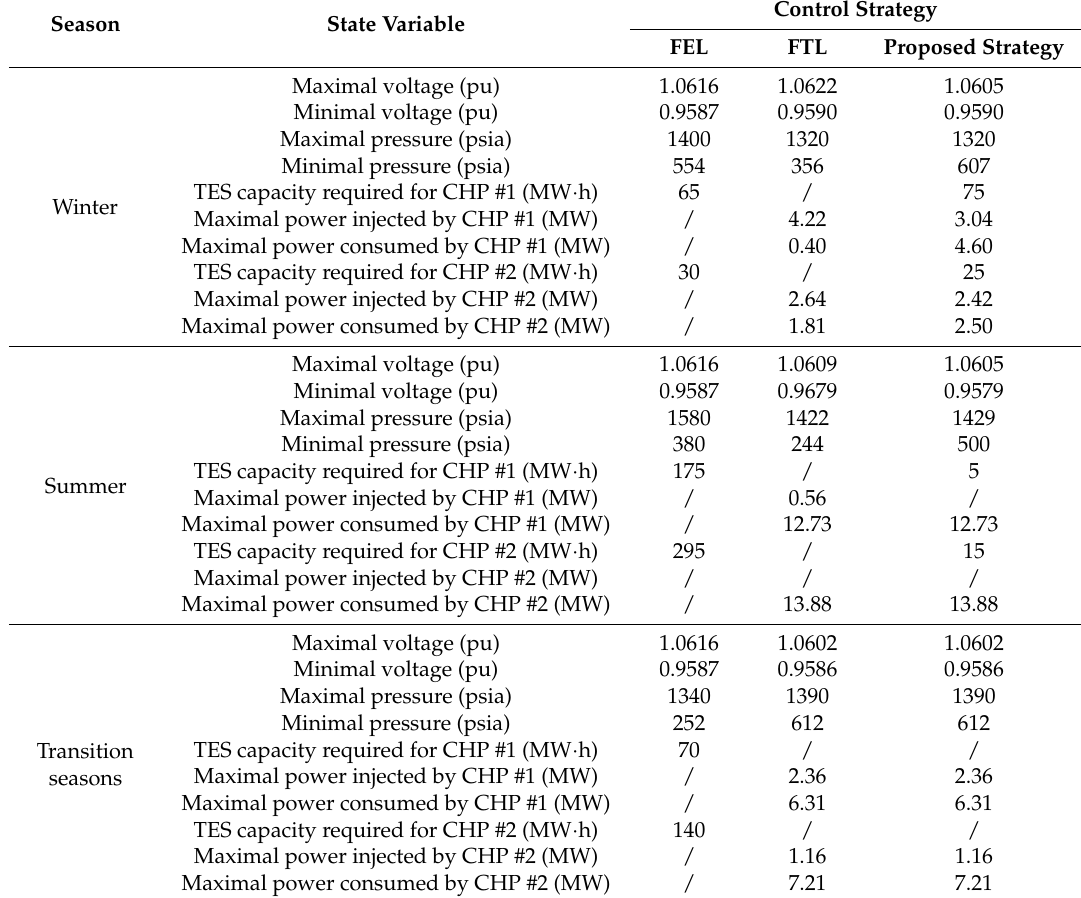
Table 8. System states under different control strategy based CHP